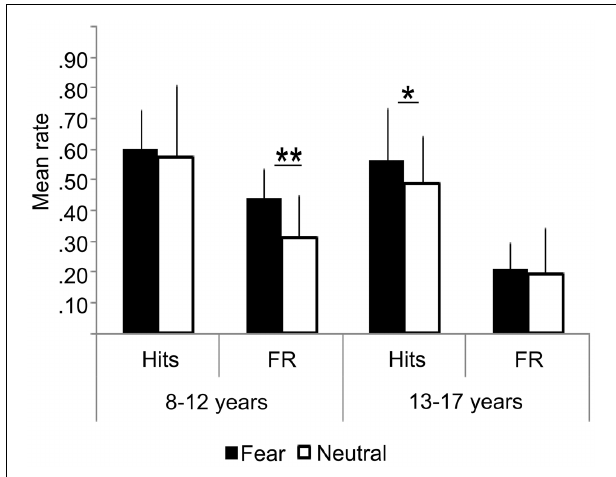
FIGURE 2 | Behavioral results: hits, False Recognition (FR) for fearful and neutral faces in children (8–12 years) and adolescents (13–17 years). Error bars = mean square errors. Significant differences between fearful and neutral conditions are indicated as follows: ∗ p < 0 . 05; ∗∗ p < 0 . 01. Fearful faces were more accurately recognized than neutral faces in the adolescents group, but not in the children group. There were more false recognitions of fearful faces than neutral ones in the children group